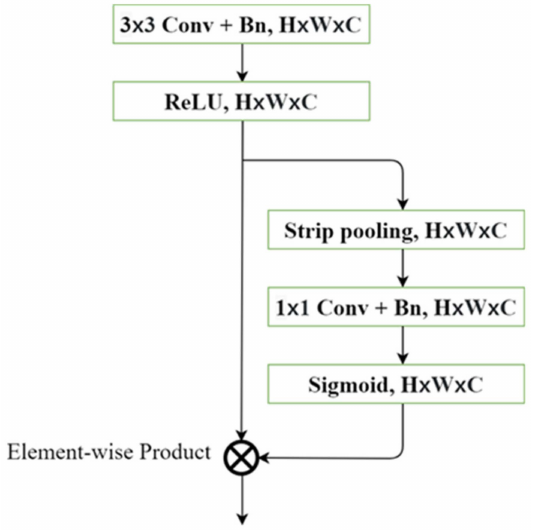
Figure 3. Refinement